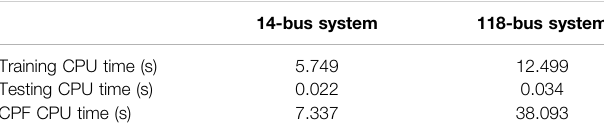
TABLE 4 | Algorithms comparison in two